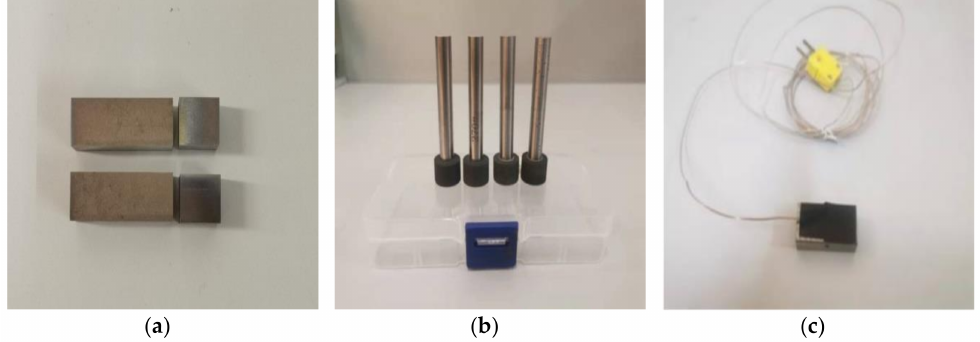
Figure 5. Workpieces, grinding wheels, and temperature test pieces used in the test. ( a ) TC4 work-